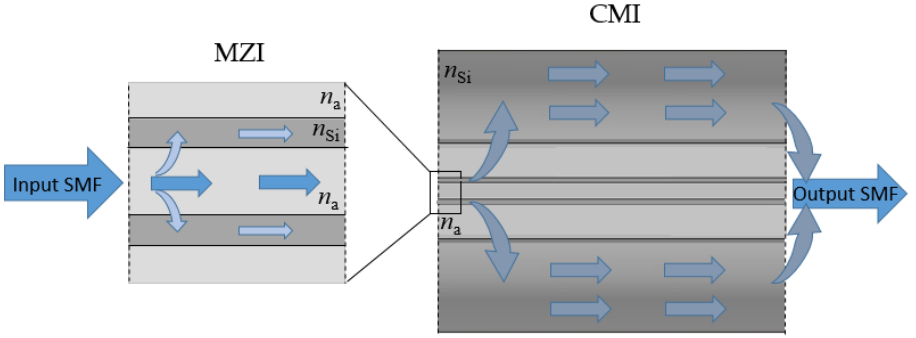
Figure 1. Scheme of the optical paths in the HSCF that originate the MZI and CMI, where n a and n Si are the refractive indices of air and silica, respectively .